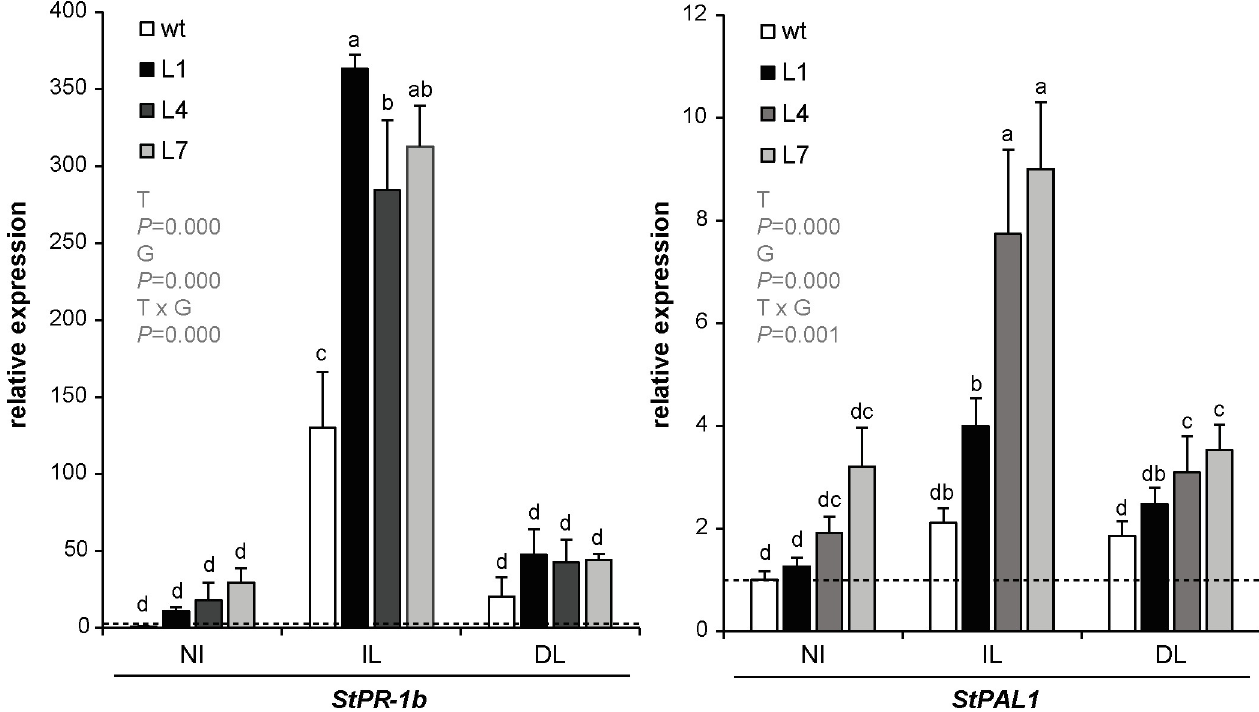
Fig 3. Expression of StPR-1b and StPAL1 in response to P . infestans infection. Wild type (wt) and PP2Ac2b-OE (L1, L4 and L7) plants were inoculated with P . infestans as described in Materials and Methods. After four dpi, expression was determined by RT-qPCR in leaves from non-infected plants (NI), infected leaves (IL) and distal leaves (DL), relative to wt NI (dashed line). Data are the mean ± SEM of of three independent experiments. Data were analyzed by two- way ANOVA, followed by Bonferroni post-hoc test ( α = 0.05) comparing the expression levels for each line (wt, L1, L4 or L7) among NI, IL and DL, and the expression levels among the different lines within each experimental condition (NI, IL or DL). P -values of the effect of treatment (T: NI, IL, DL), genotype (G: wt, L1, L4, L7) and their interaction are shown. The two-way ANOVA showed a significant interaction between the effects of T and G, and a significant effect of T and G on the expression levels of StPR-1b and StPAL1